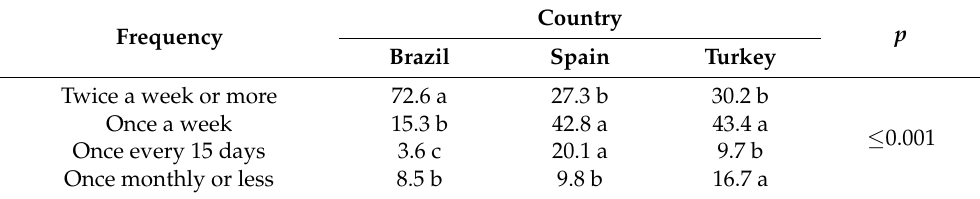
Table 1. Frequency of beef intake among consumers in Brazil, Spain, and